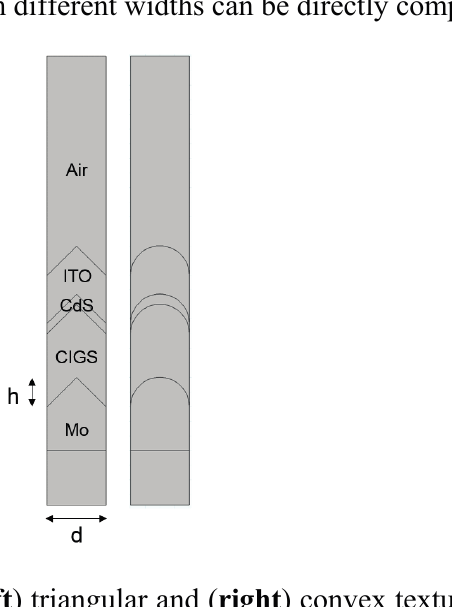
Figure 1. Used model geometry; ( left ) triangular and ( right ) convex texture features, with two variable parameters: texture height ( h ) and width ( d ).